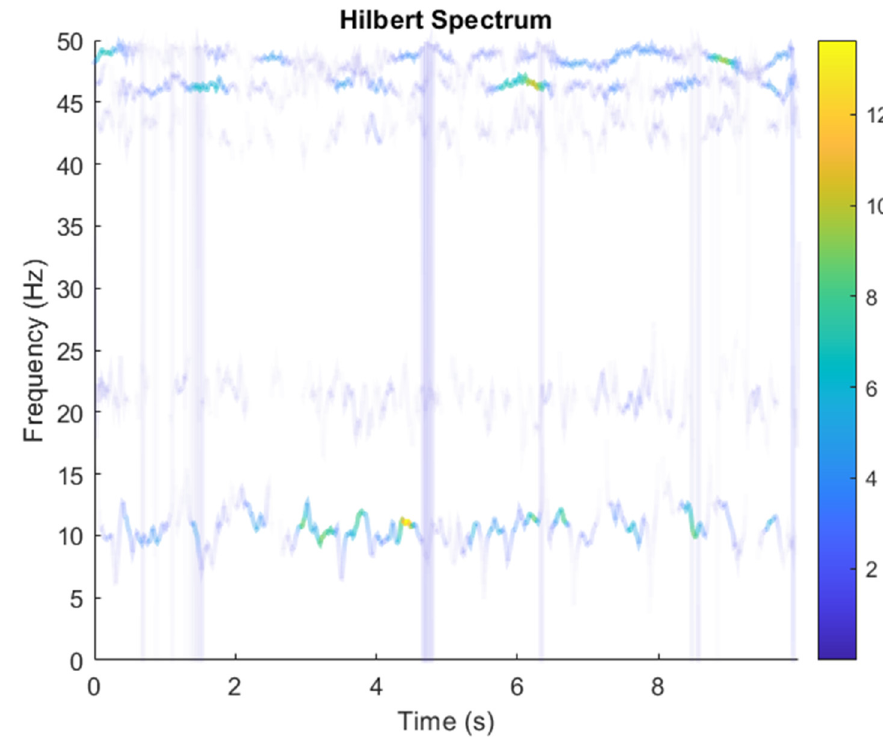
Figure 11. Analysis of data separated by VMD-ICA’s Hilbert Spectrum results.